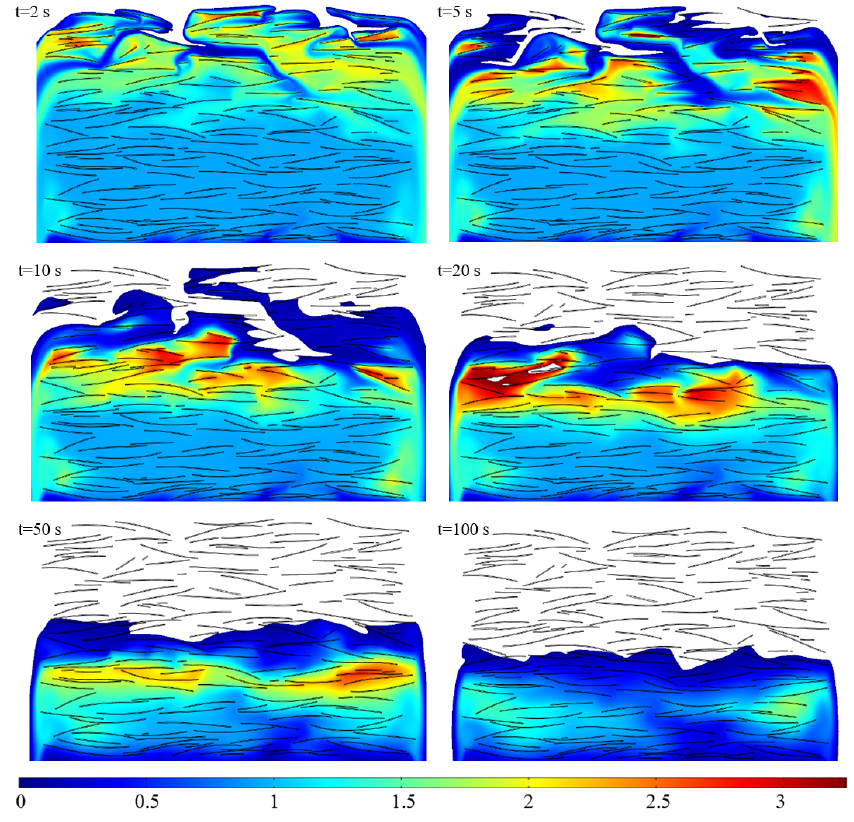
Figure 7. Evolution of vapor concentration in heaped tobacco strips (section i , thickness, 60 mm, unit: mol · m − 3 ).